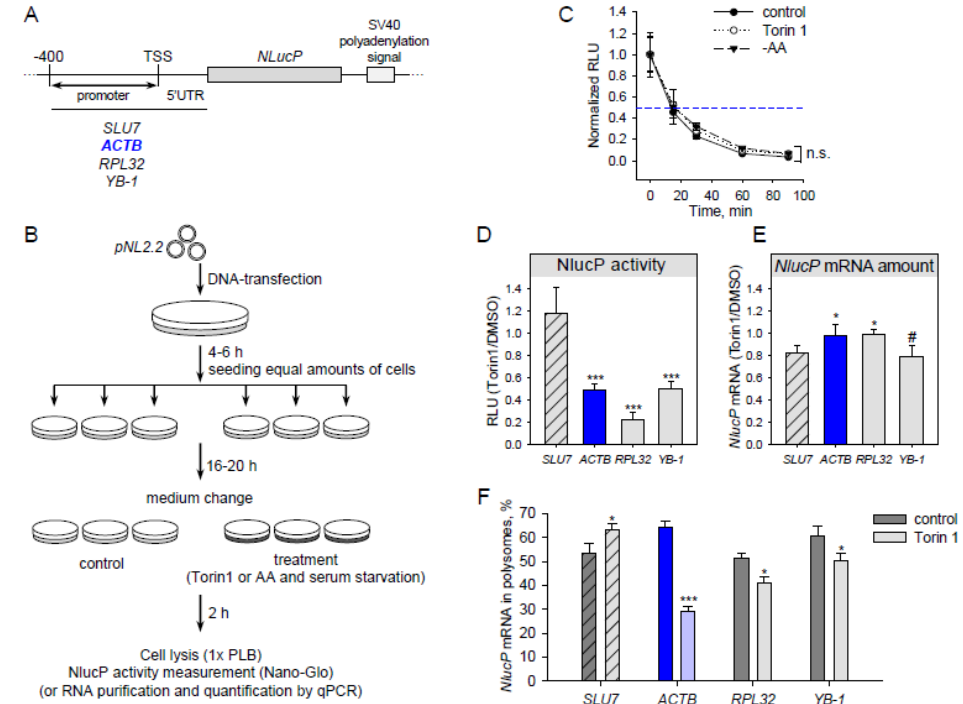
Figure 1. Translation of reporter mRNA with β -actin 5’UTR is sensitive to mTOR (mammalian target of rapamycin) inhibition. ( A ) Scheme of the pNL2.2 plasmid used in this study (TSS—transcription start site). ( B ) Scheme of an experiment with pNL2.2 . Cells were transfected with pNL2.2 ; after 4-6 h equal amounts of cells with the same transfection were seeded to smaller dishes to grow for 16-20 h. Cells were treated for 2h with DMSO (control) or 500 nM Torin1 or subjected to amino acid starvation (EBSS—Earle’s balanced salt solution). Two hours later, luciferase activity or mRNA abundance was measured. ( C ) HEK293T cells were transfected with pNL2.2-SLU7-NlucP ; 24 h later the cells were treated with DMSO (control) or 500 nM Torin1 or EBSS (-AA) for 2 h, then CHX was added for 0, 15, 30, 60, or 90 min. After that, luciferase activity was measured. For each condition, the luciferase activity ( Y -axis) was normalized to the value at the zero min time point. ( D – F ) HEK293T cells were transfected with pNL2.2 . After 2h cell treatment with DMSO (control) or 500 nM Torin1 they were collected and luciferase activity ( D ), NlucP mRNA abundance ( E ), and polysome distribution ( F ) were measured. A polysome fraction was calculated as (mRNA in polysome)/(mRNA in polysome + mRNA in subpolysome). Values are the means of at least three independent experiments. Error bars show standard deviations. Student’s t -test was used to estimate the statistical significance versus the SLU7 control ( D,E ) or versus control treatment (C,F) , *** p < 0.001; * p < 0.05; #, n.s., nonsignificant.